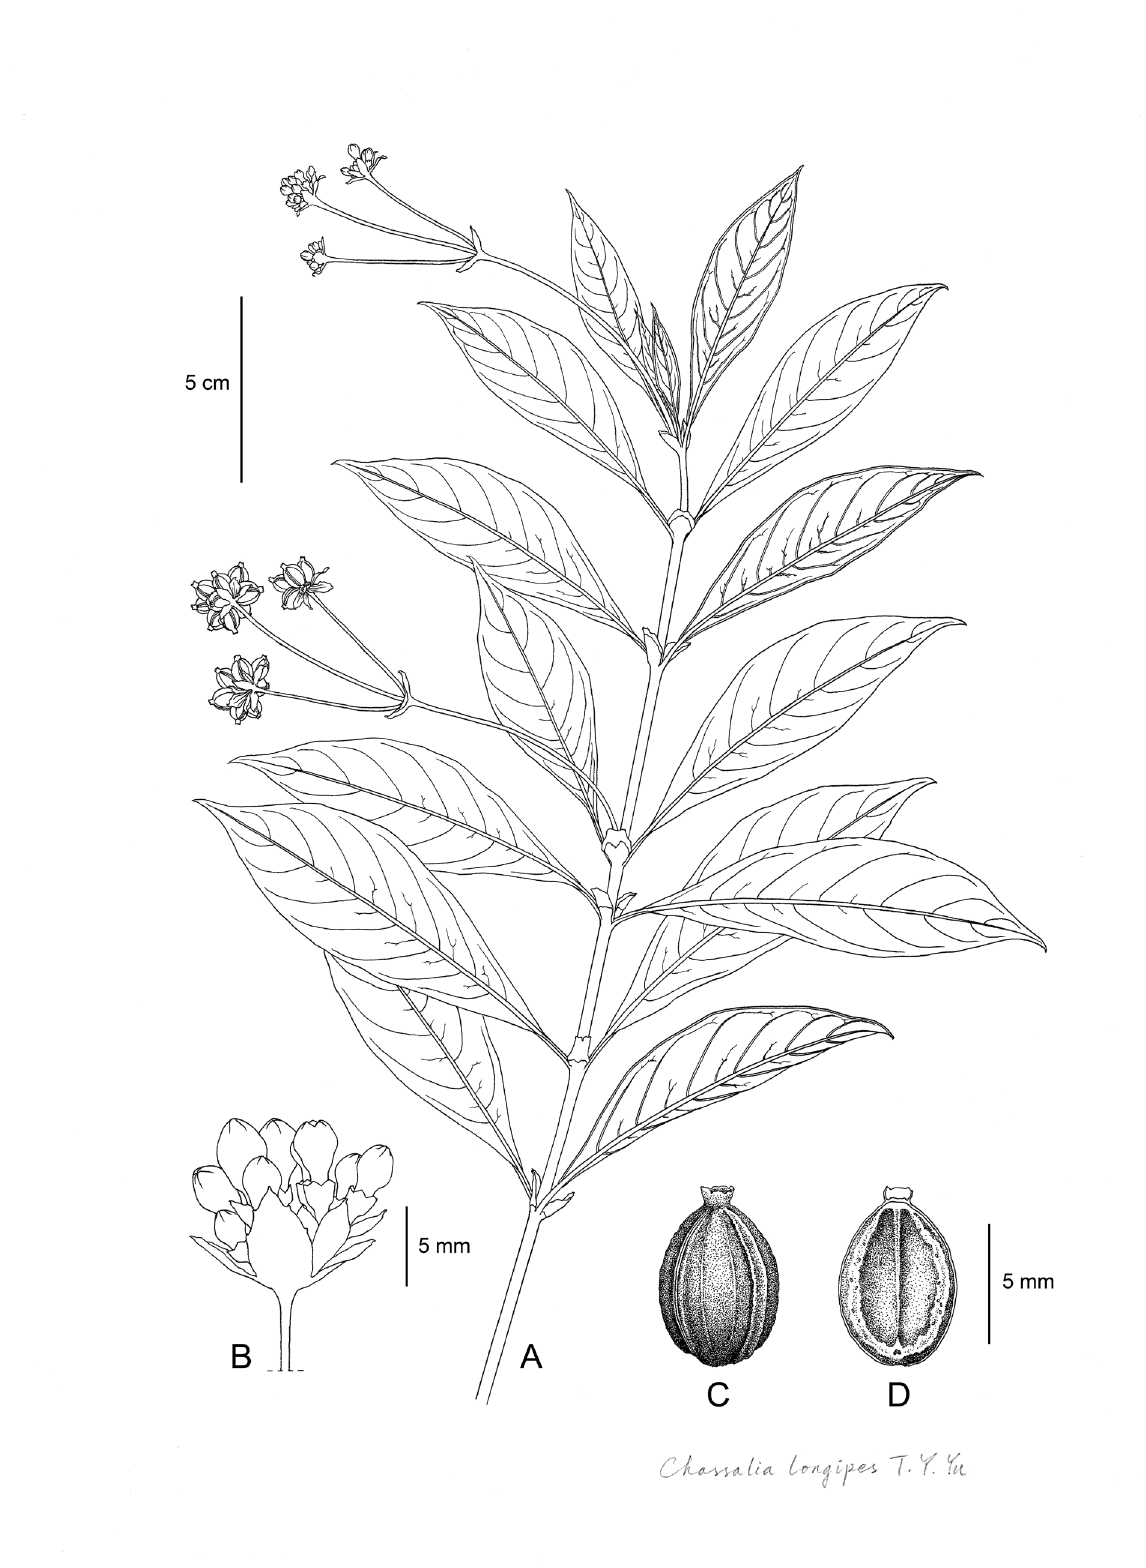
Fig. 20. Chassalia longipes T.Y.Yu sp. nov. A . Flowering shoot. B . Capitulum. C . Dry fruit. D . Pyrene ventral surface. A, C–D from Teofila E. Beaman 275 ; B from John H. Beaman 10681 . Drawn by T.Y.